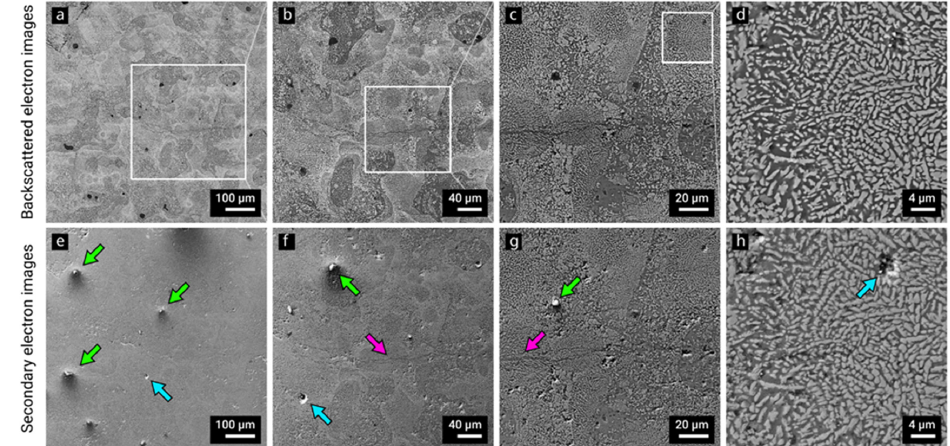
Figure 5. Top surface backscattered electron ( a – d ) and secondary electron (SE) images ( e – h ) of TiB 2 -Si bulks printed by SLM at 2200 mA laser current. Unmelted or partially melted particles are pointed out by green arrows; pores and surface defects are pointed out by blue and pink arrows, respectively.